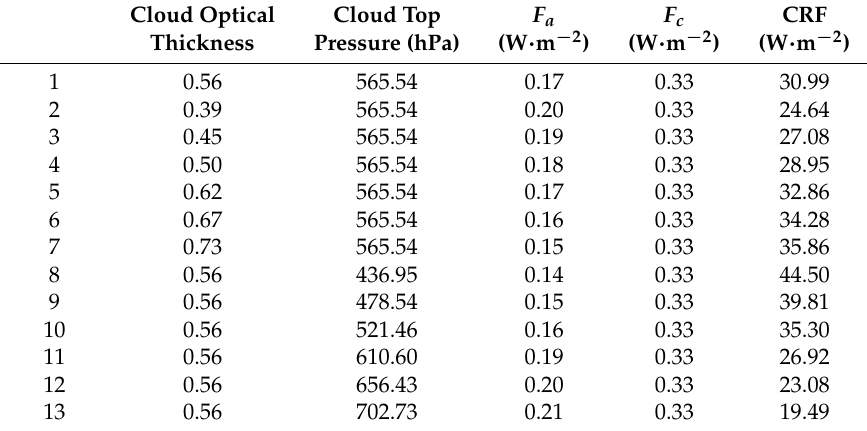
Table 8. NF 3 instantaneous radiative forcing at the top of the atmosphere with different cloud optical thicknesses and different cloud top pressures with the concentration of 1.0 ppb. CRF, cloud radiative